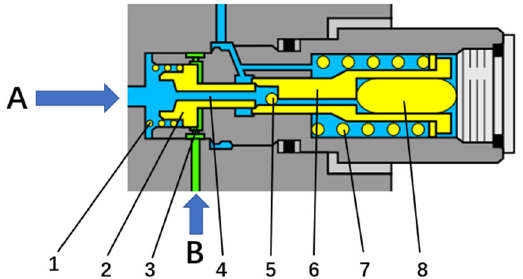
Figure 9. Working principle diagram of anti-vibration valve: 1-seat spring; 2-valve seat; 3-damped holes; 4-hole in the seat; 5-ball valve; 6-plunger; 7-plunger spring; 8-piston.